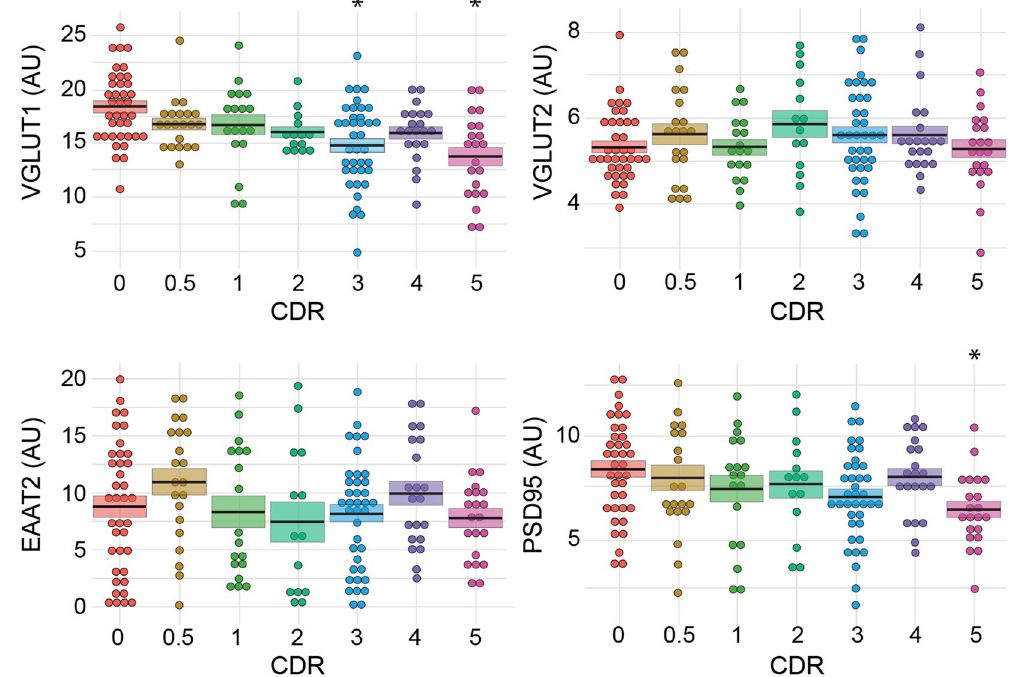
Figure 3. Dot plot representation of the effect of dementia on the expression of glutamatergic markers. VGLUT1, VGLUT2, EAAT2 and PSD95 were measured by western blot coupled to infrared detection and the expression levels (in arbitrary units) were plotted against the CDR scores. Values for each individual are represented by dots. The mean is depicted as the black line in the middle of a box representing the SEM. VGLUT1 expression was significantly reduced at CDR scores of 3 and 5 ( p < 0.05), whereas VGLUT2